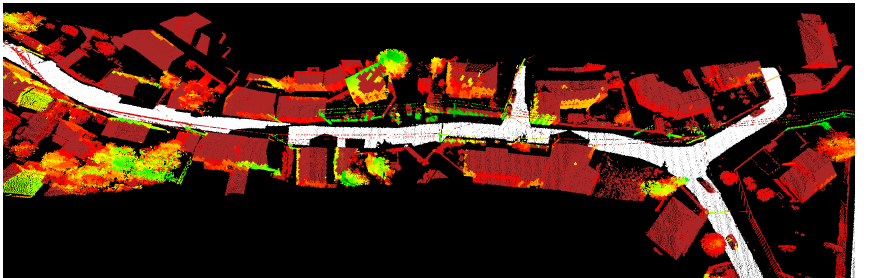
Figure 7. Vertical range in the most detailed scale, KNN = 25.